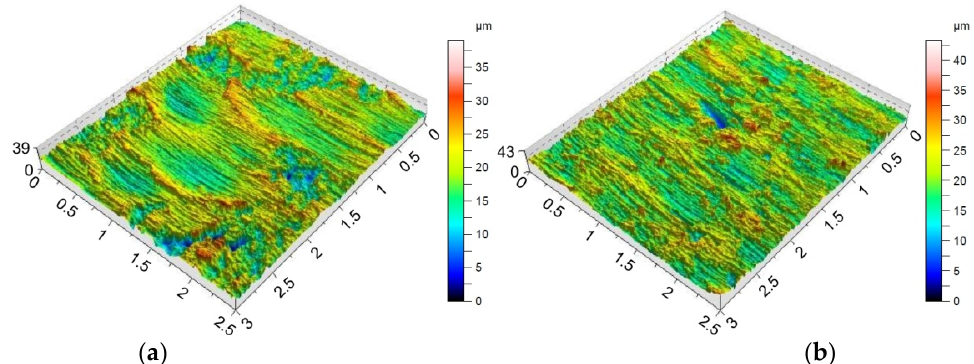
Figure 8. Topography of inside surface of the drawpieces formed at a p = 0.5 mm, f = 500 mm/min, n = 600 rpm and toolpath strategy: ( a ) conventional and ( b ) climb.